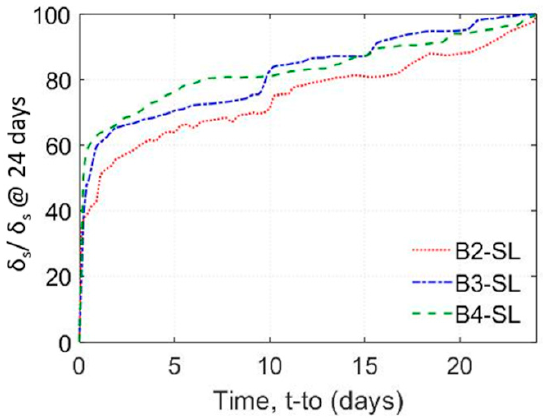
Figure 16. Percent increase in deflection with time beams series I.